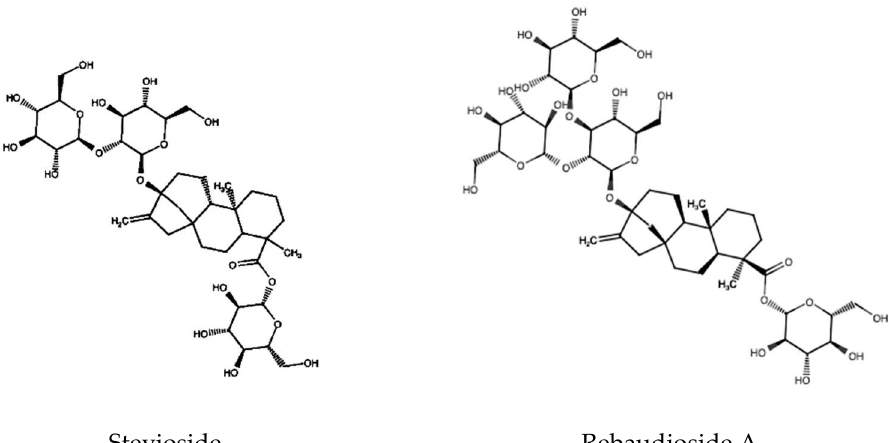
Figure 1. Structure of the main steviol glycosides in S. rebaudiana.